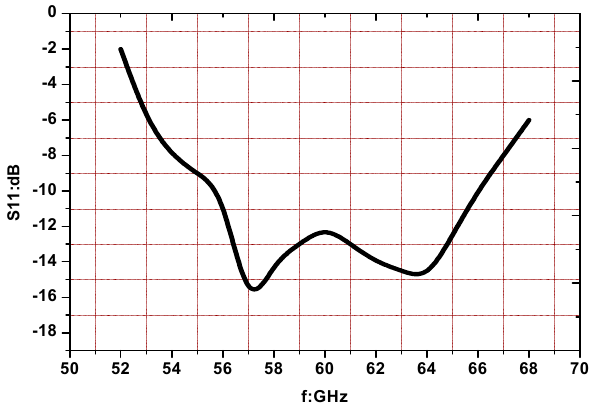
Figure 2. S parameter of Yagi-Uda antenna.